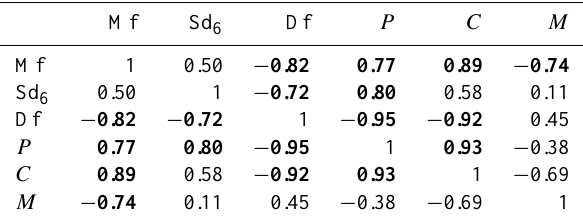
Table 3. Linear correlation coefficients between the metrics tested to analyse the statistics of zero flow periods in the basins studied. Values in bold are significant at the p < 0 . 05